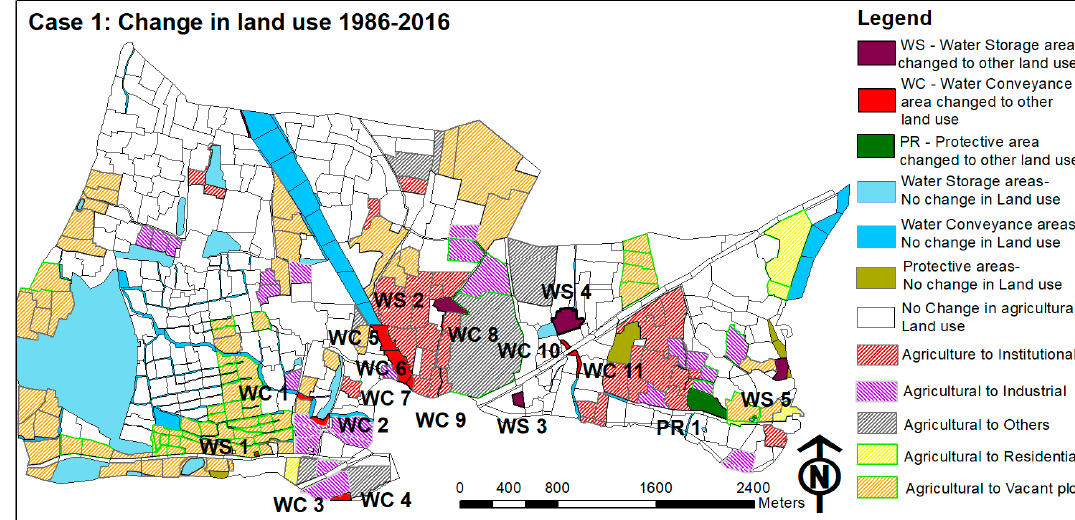
Figure 6. Trends in land use change components within agricultural land and common land for case 1 and case 2.